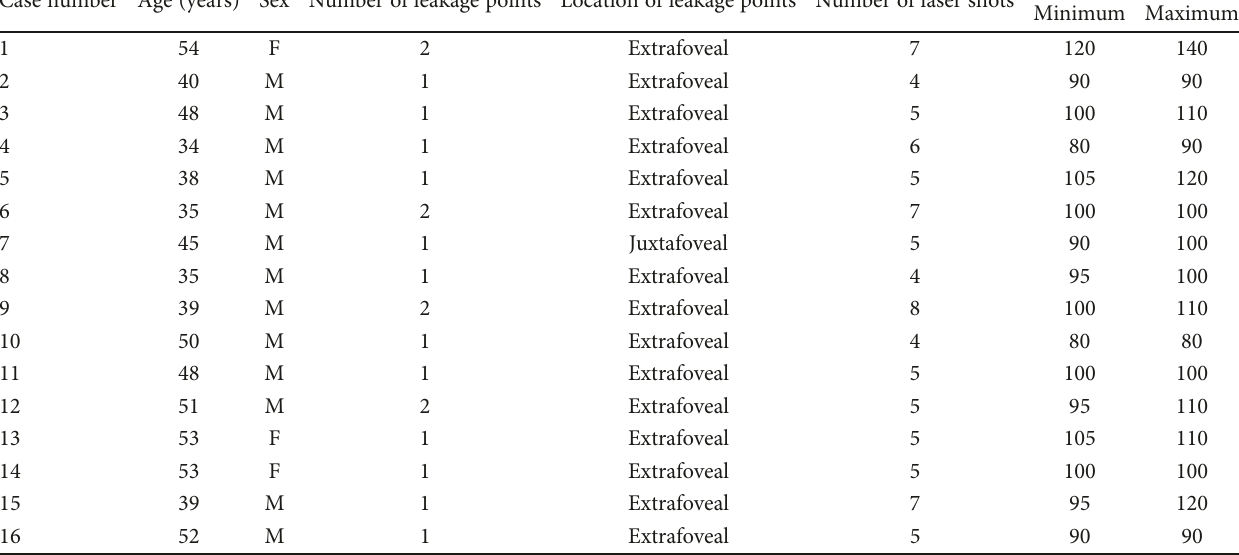
Table 1: Baseline characteristics and treatment for 16 included